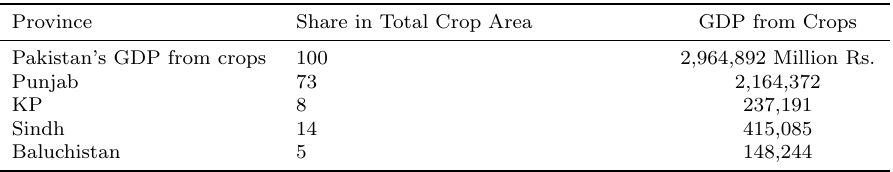
Table 4: Provincial shares in crop area and crop sector GDP in 2017-18 Province Share in Total Crop Area GDP from Crops Pakistan’s GDP from crops 100 2,964,892 Million Rs. Punjab 73